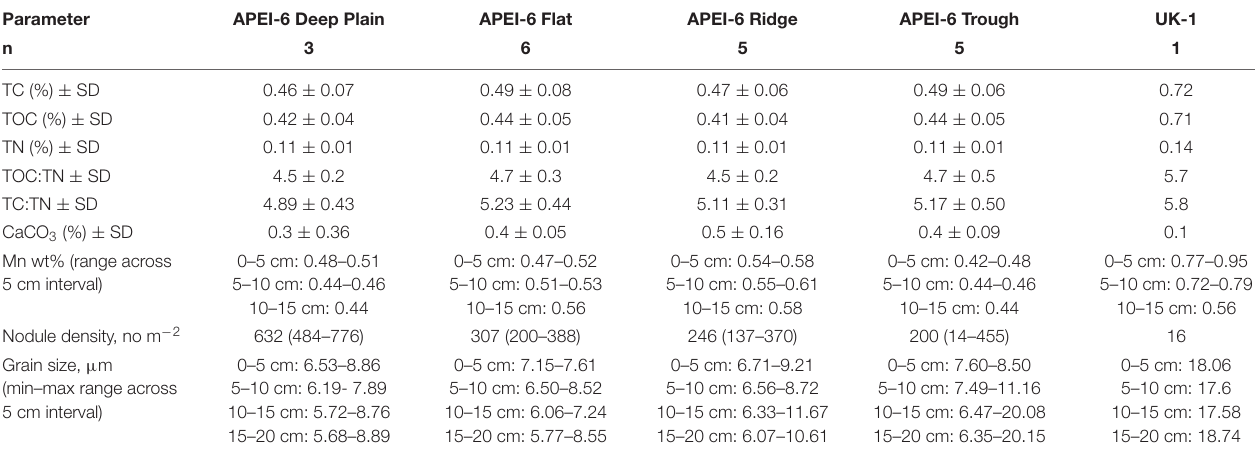
TABLE 3 | Sediment biogeochemistry and environmental data for each APEI-6 SW landscape type and UK-1 (UK Seabed Resources Limited eastern contract area) which were collected during cruise JC120 (Jones et al., 2021, in